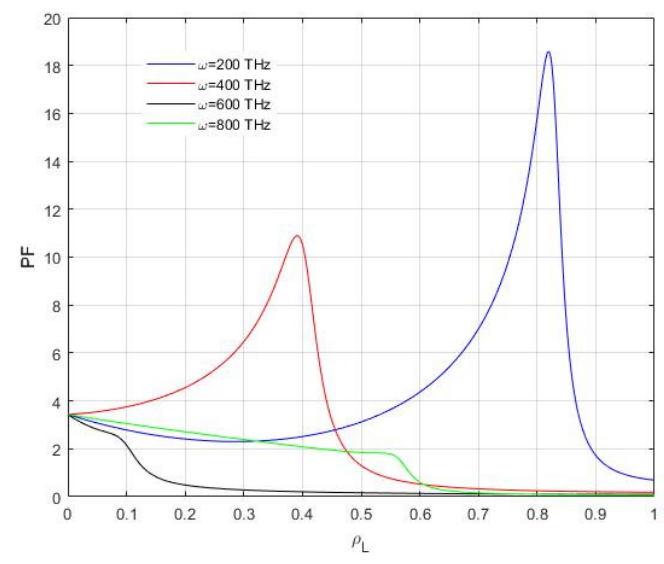
Figure 7. Purcell factor versus filling ratio ρ .